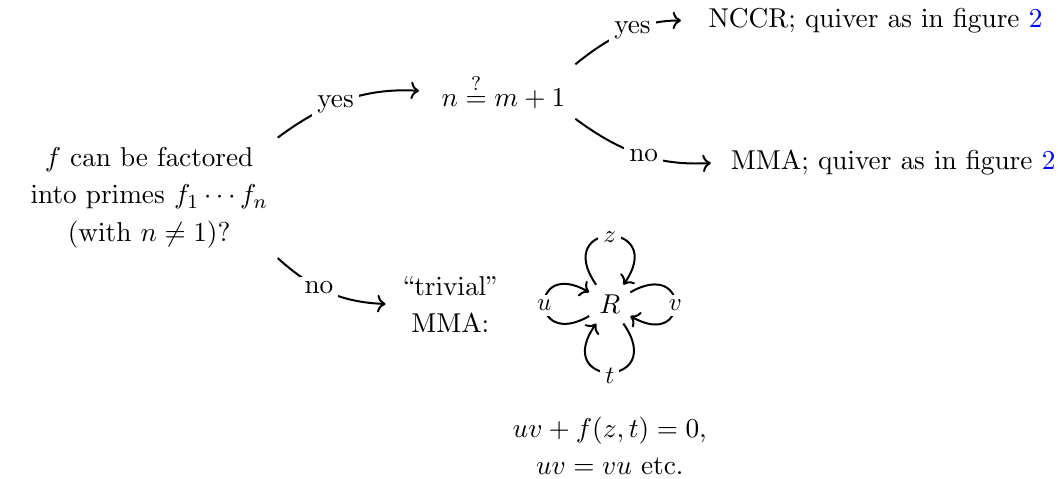
Figure 9. The various possibilities given the cA